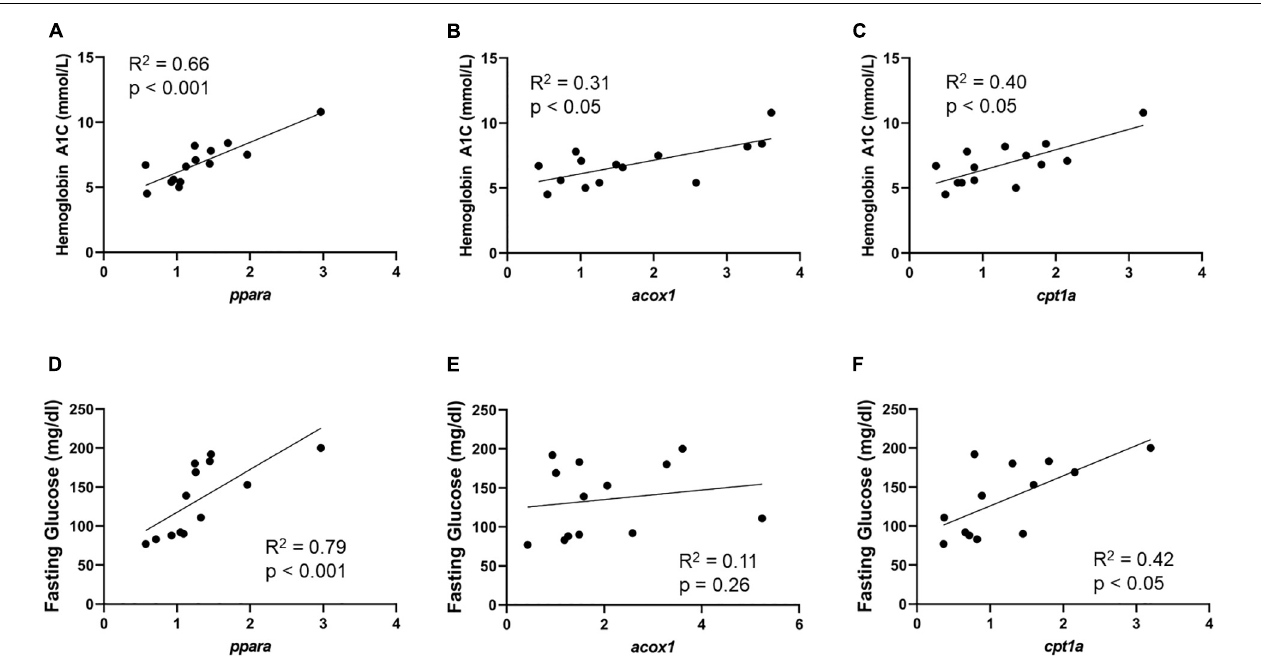
FIGURE 4 | Min carotid plaque mRNA correlates with HbA1c, and fasting glucose content. (A–C) Min-diseased carotid plaque mRNA content demonstrates significant positive correlation between ppara ( p < 0.0001, R 2 = 0.66, n = 14), acox1 ( p < 0.05, R 2 = 0.31, n = 14) and cpt1a ( p < 0.05, R 2 = 0.40, n = 14) in comparison to HbA1c content. (D–F) Min-diseased carotid plaque ppara ( p < 0.001, R 2 = 0.79, n = 13), and cpt1a ( p < 0.05, R 2 = 0.42, n = 13) Demonstrates significant positive correlation with fasting glucose levels. We did not observe a correlation between acox1 ( p = 0.26, R 2 = 0.12, n = 13) and fasting